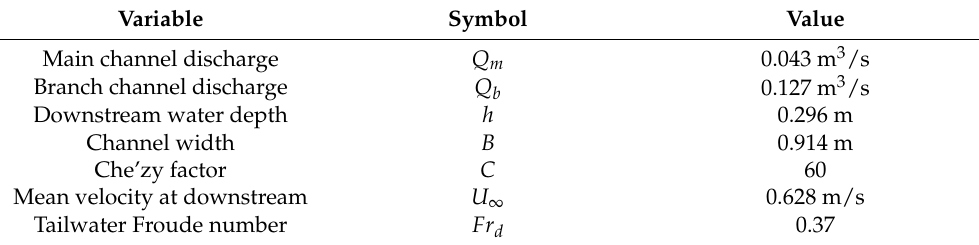
Figure 12. The confluent channel model (Shaheed et al., 2018) [14]. Table 4. The flow conditions and dimensions of the confluent channel (developed from Shumate) [23].